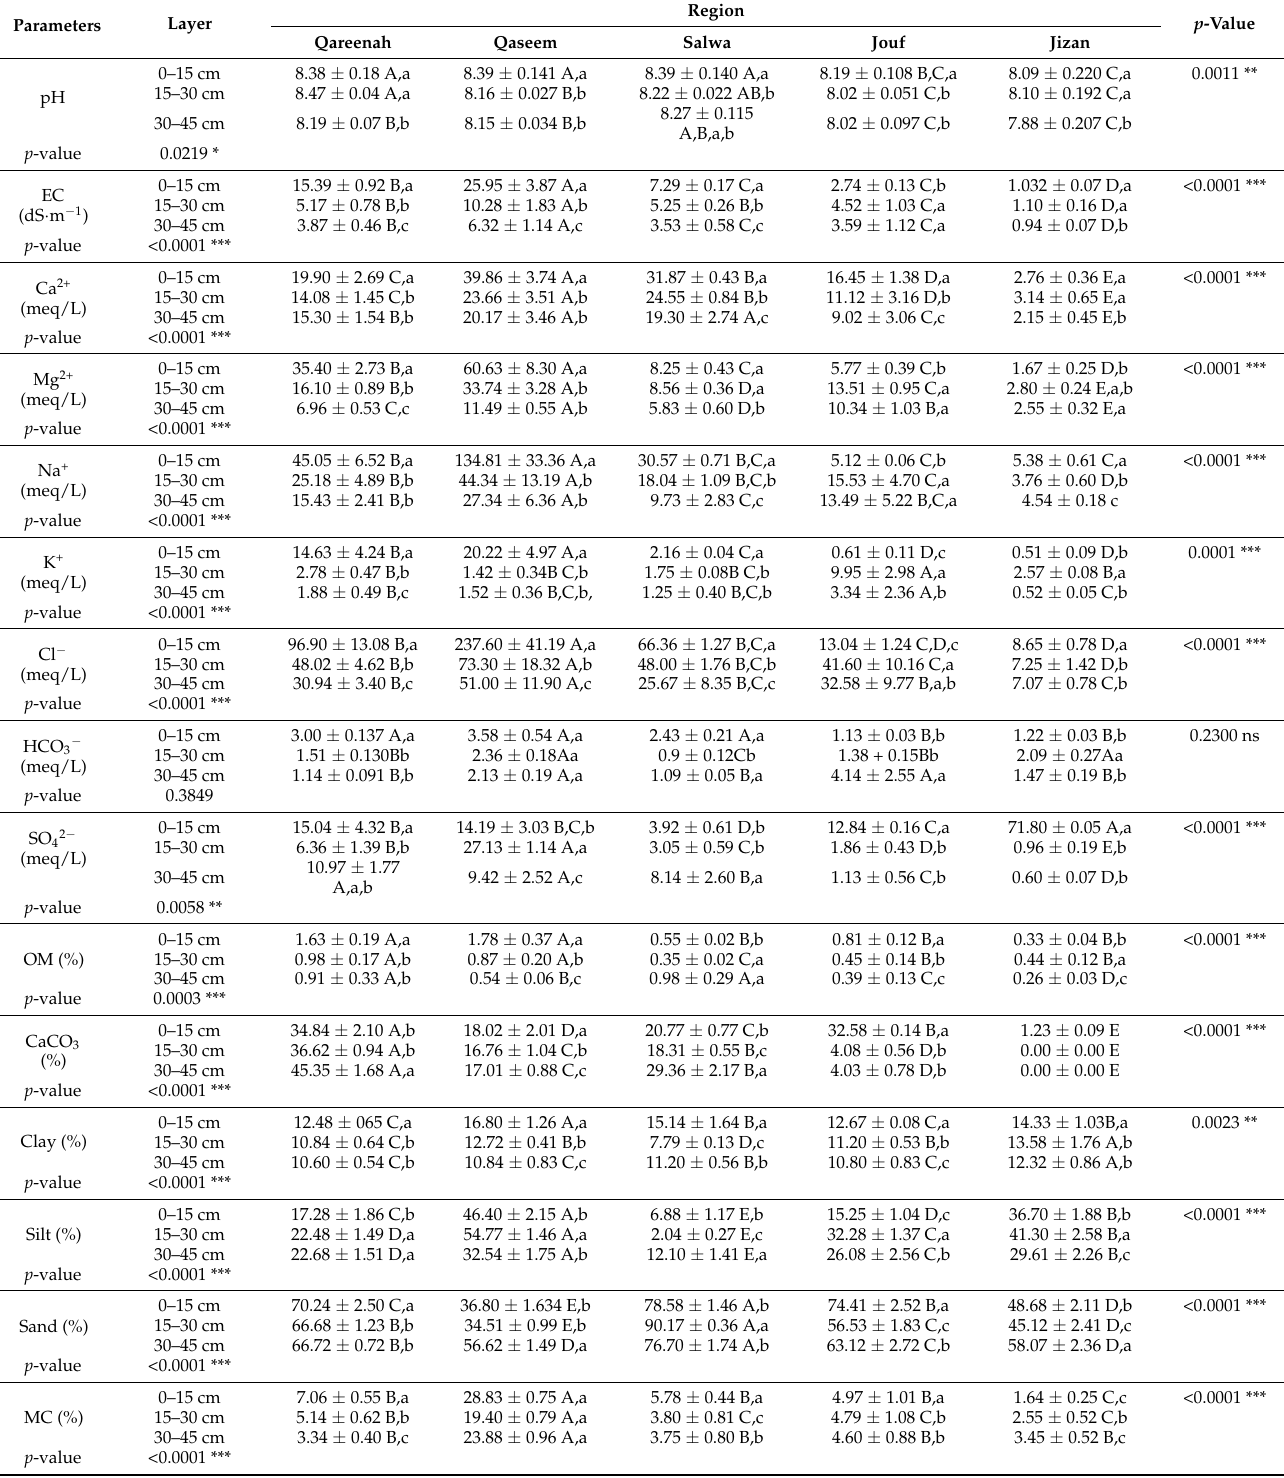
Table 1. Physical and chemical properties of different soil layers supporting Aeluropus lagopoides in different